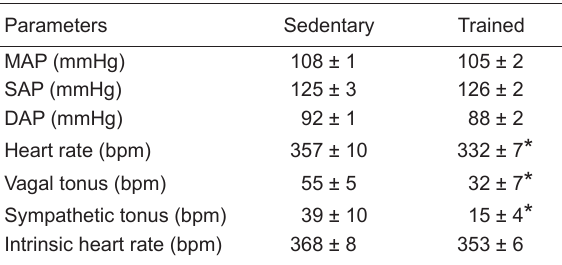
Table 1. Cardiovascular and autonomic evaluations of the seden - tary and trained female rats. Parameters